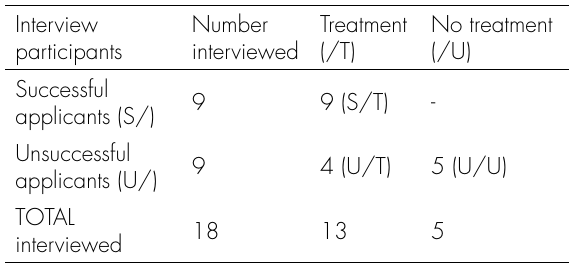
Table I. Interview participant treatment